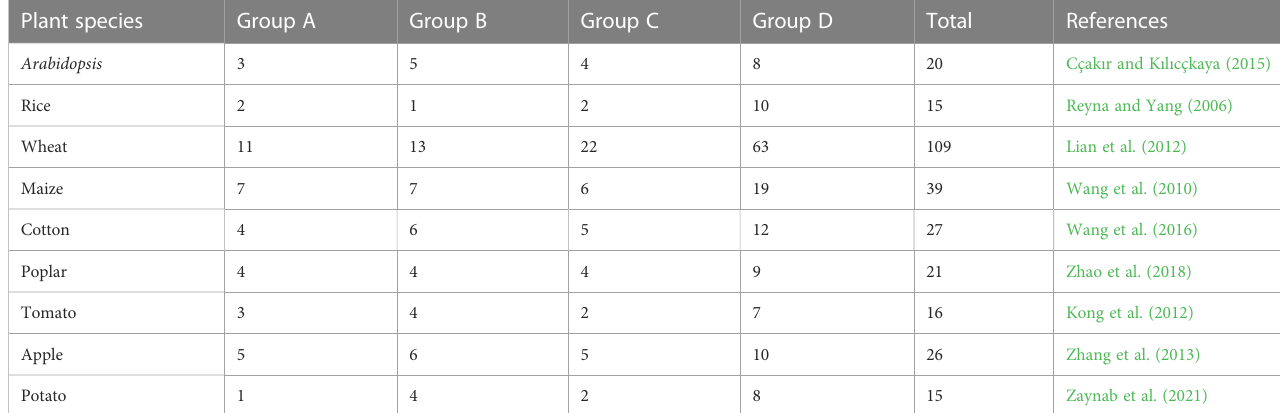
TABLE 1 Identi fi cation of groups of MAPK gene families in different plant species. Plant